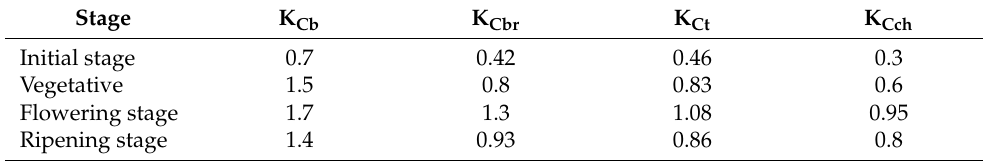
Table 4. Kc values of BARI bottlegourd-3, BARI Tomato-3, BARI Brinjal-8 and Bogra Local